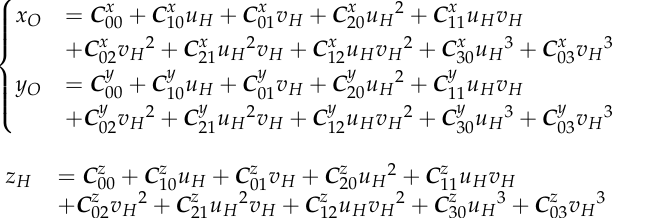
Figure 11. The vertical line intersects the curved triangle: ( a ) the projection point (Z-direction); ( b ) location of projection point. Taking a vertical line along the Z-direction as an example, when the triangle in the Hermite model intersecting the vertical line is determined, the parameter value of the sampled mapping point on the Hermite surface triangle can be found by Equation (16). The vertical coordinates of the sampling mapping points (e.g., Equation (16)) can be ( ) , u v into Equation (14). obtained by substituting H H